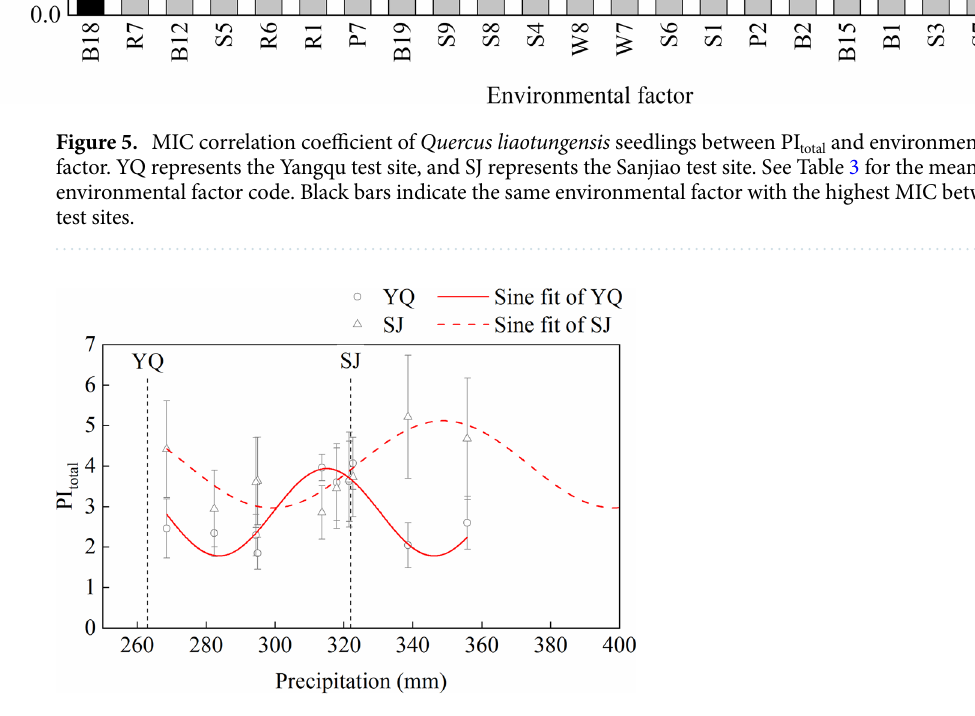
Figure 6. Regression analysis of Quercus liaotungensis seedlings between PI total and precipitation of the warmest quarter in provenance. YQ represents the Yangqu test site, and SJ represents the Sanjiao test site. The dotted lines indicate the precipitation of the warmest quarter in two test sites. R 2 of Sine fit of YQ is 0.90, P < 0.01, and R 2 of Sine fit of SJ is 0.77, P <